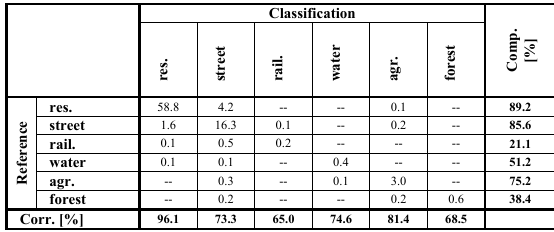
Table 3: Confusion matrix obtained by classification using the CRF approach with correctness (corr.) and completeness (comp.) values [%] for the land use classes res. , street , rail. , water , agr. and forest